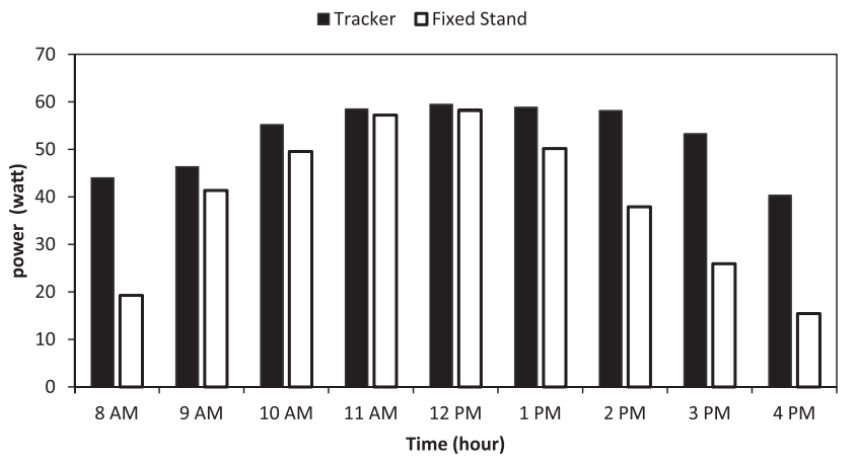
Figure 13. The hourly power output of the solar tracker versus fixed stand. Reprinted from Renewable Energy, 60, Adinoyi M. et al., Effect of dust accumulation on the power outputs of solar photovoltaic modules, 635., Copyright (2013), with permission from Elsevier [31].